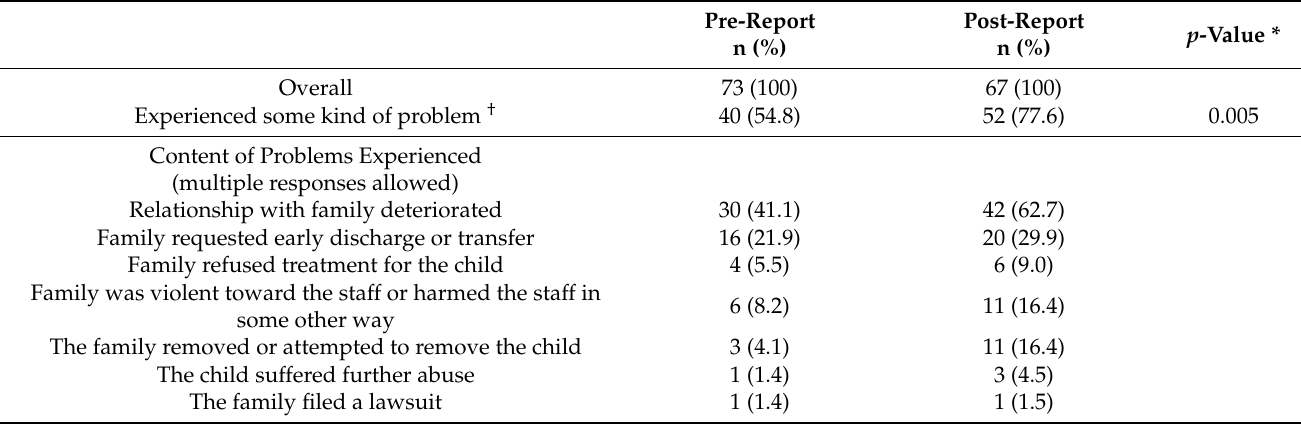
Table 6. Difficulties arising and timing of